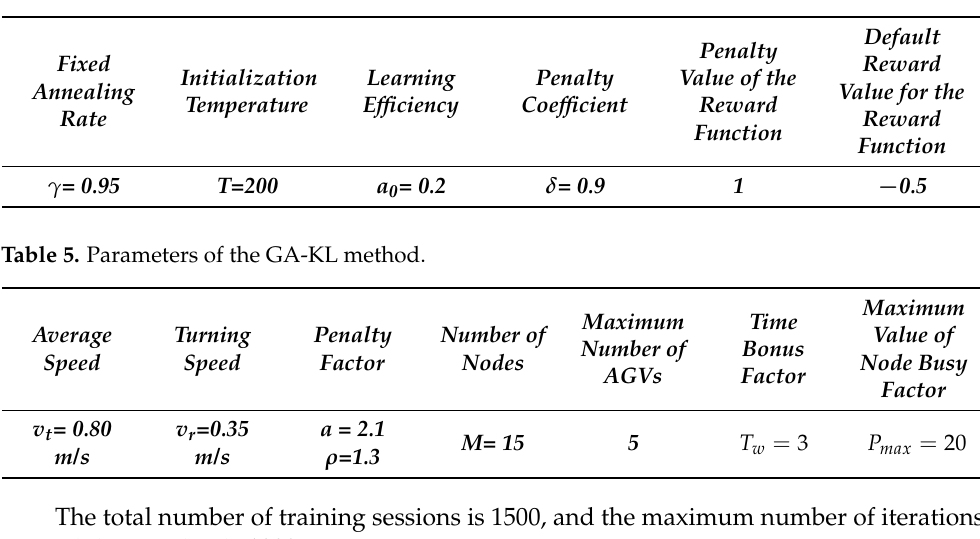
Table 4. Parameters of the K-L algorithm.